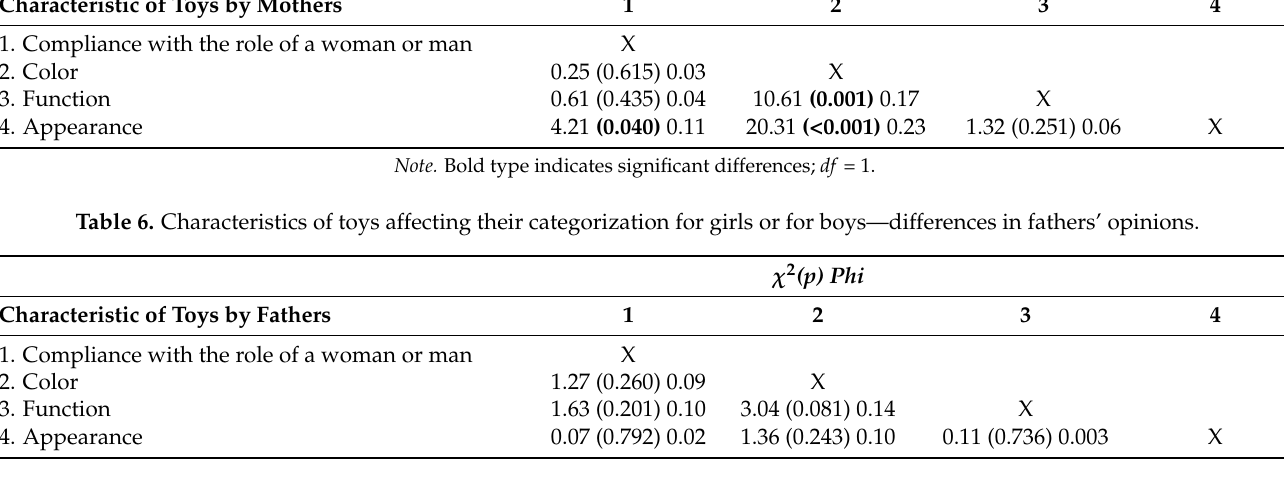
Table 5. Characteristics of toys affecting their categorization for girls or for boys—differences in mothers’ opinions. Characteristic of Toys by Mothers